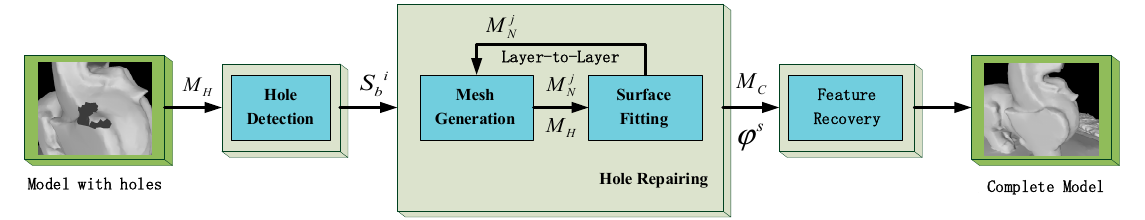
Figure 3. The proposed LIMOFilling overview, showing all the steps performed by the hole-detection, hole-repairing, and feature-recovery.